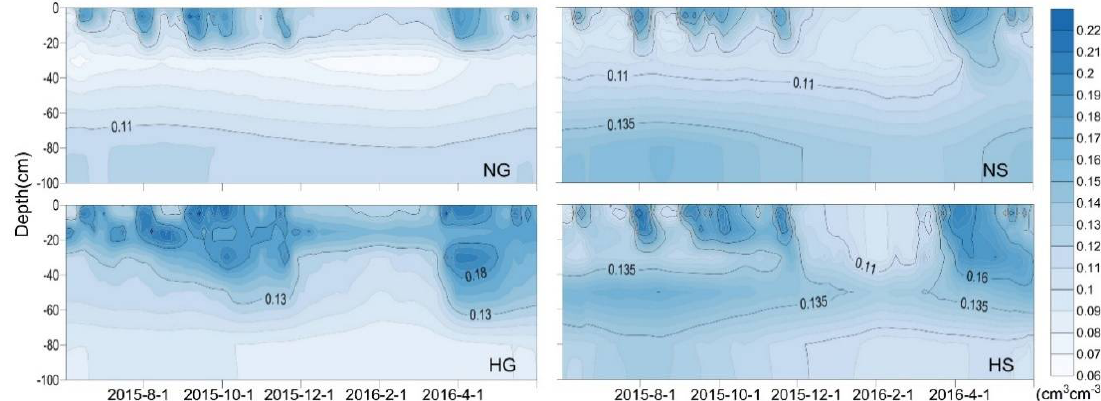
Figure 2. The volume water content (VWC) (cm 3 cm −3 ) dynamics by temporal interpolation across a year (June 2015 to May 2016).